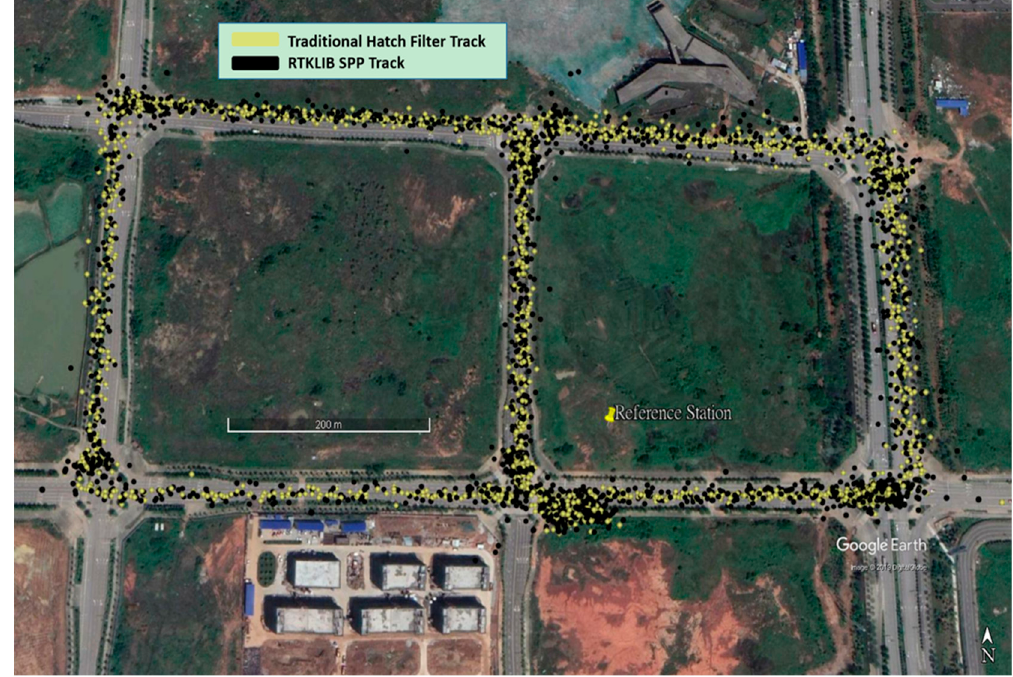
Figure 11. The track of the SPP (Single Point Positioning) solution ( black dots ) and the track of the traditional Hatch filter ( yellow dots ) with a 600s-window solution.